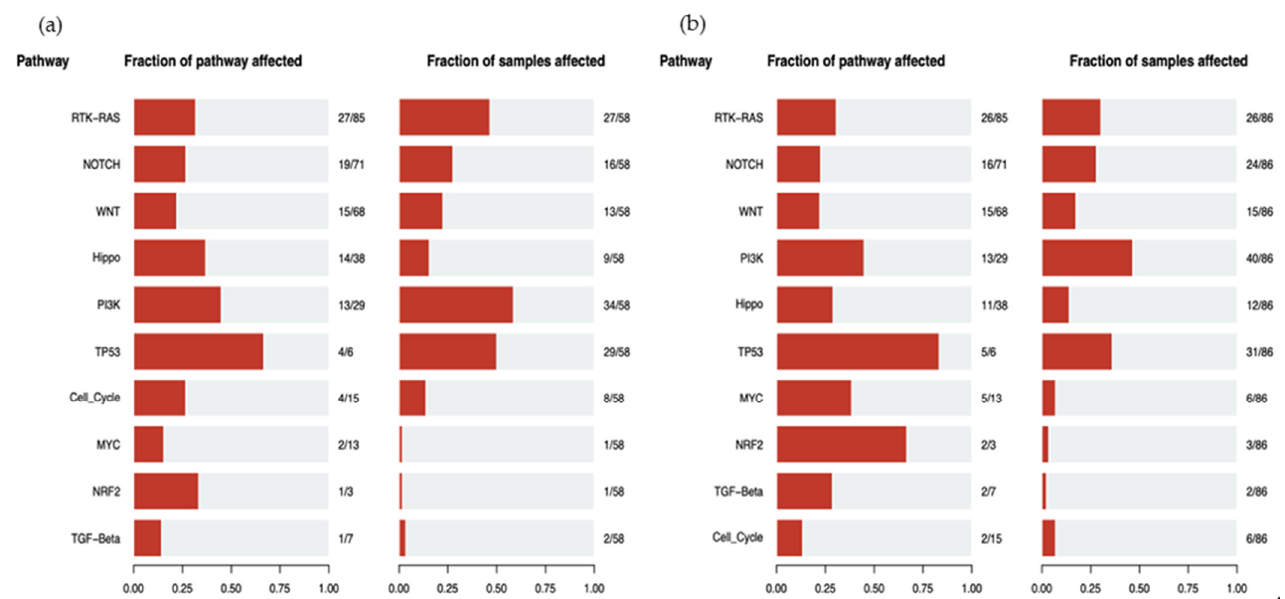
Figure 9. ( a ) Altered pathways according to the number of mutated genes and according to the number of samples affected in cutaneous metastasis. ( b ) Altered pathways according to the number of mutated genes and according to the number of samples affected in liver metastasis.